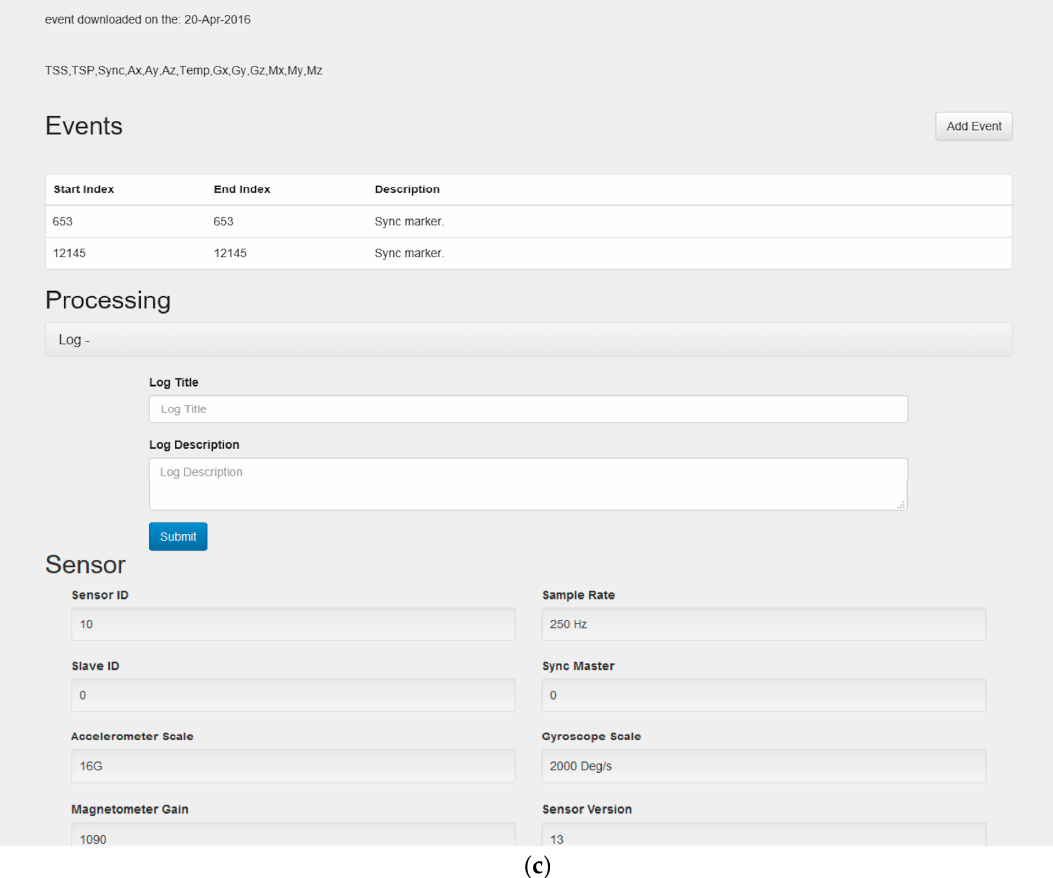
Figure 5. ( a ) Operator uploading several data sources for a newly created session; ( b ) operator session with six data sources shared with multiple operators; and ( c ) detailed dataset information with time-series dataset rendering.